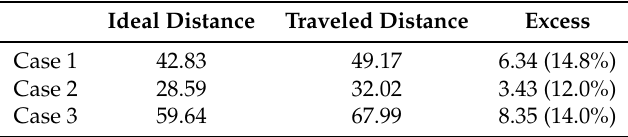
Table 8. Traveled distance vs. ideal case (Units: meters).